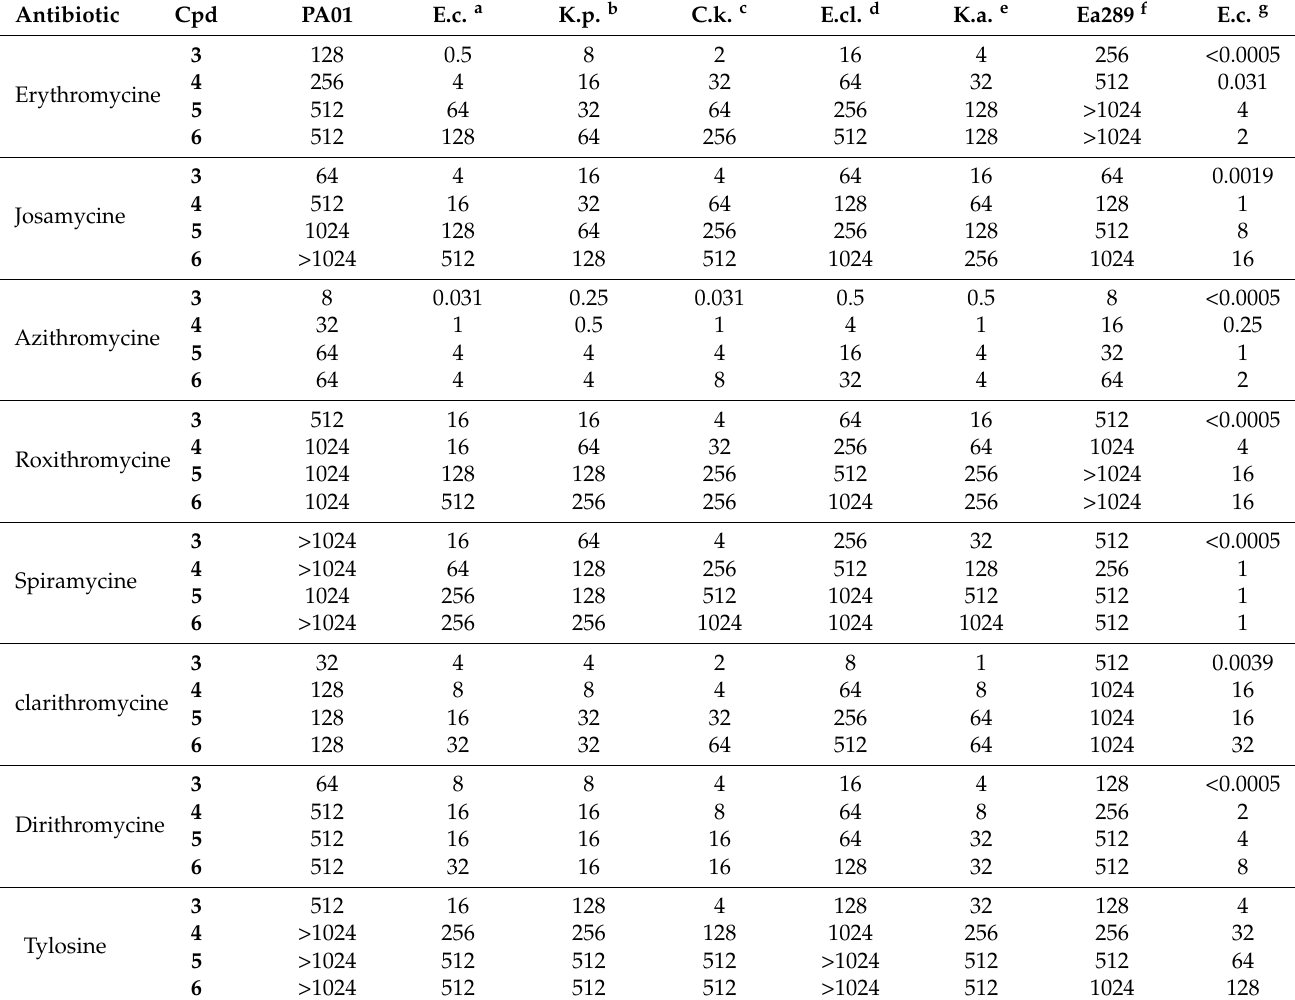
Table 4. Restoration of macrolides activity (MIC values in µ g/mL) against various Gram-negative bacteria in the presence of a 10 µ M concentration of derivatives 3 – 6 .